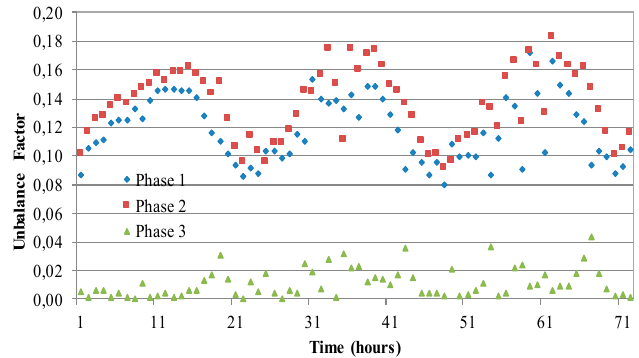
Figure 4. Unbalance factor for each phase and period.